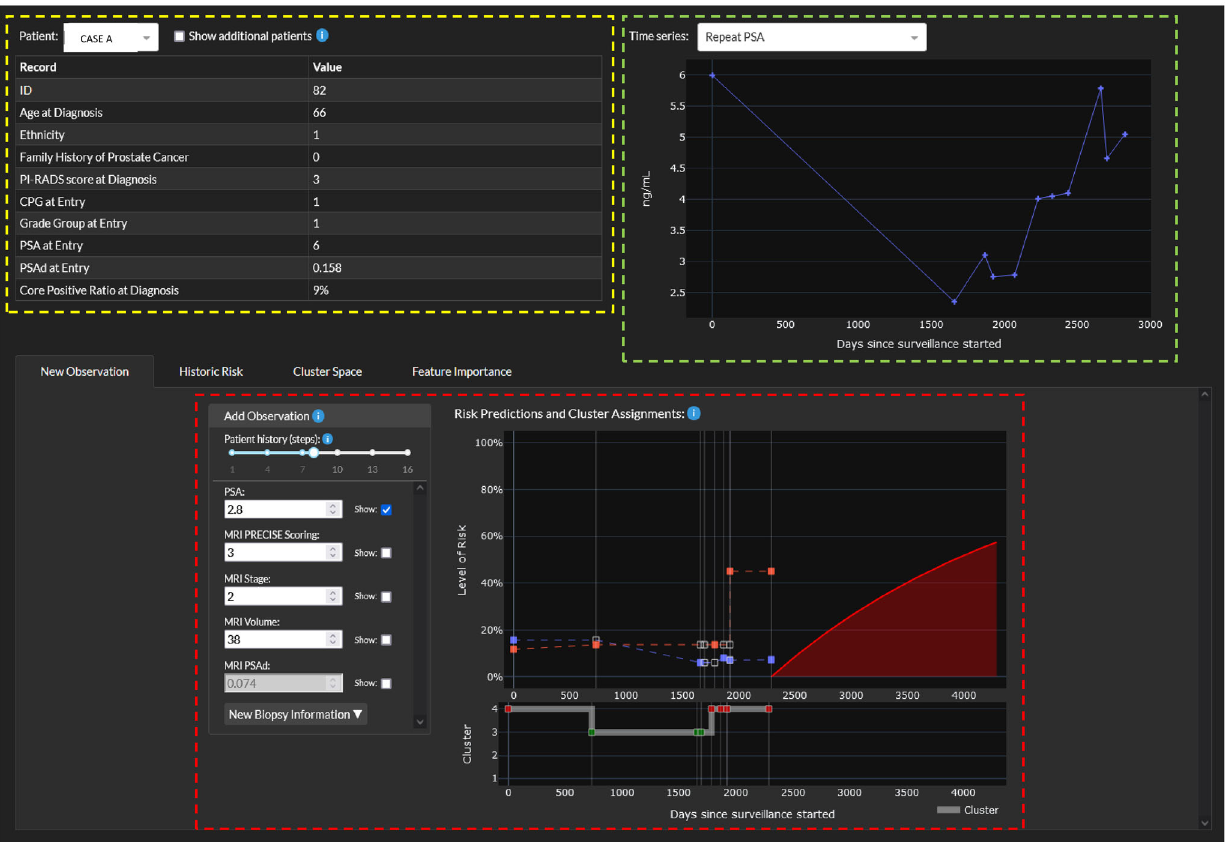
Fig. 4 Representative image from a demonstration interface of how the DDHL and AC-TPC algorithms would work in practice. (available at https://demo-dynamic-tte.herokuapp.com). Yellow box - data display on the patient ’ s baseline demographics. Green box - history of sequential readings, in this display PSA readings over time since starting AS. Red box - when a new data point is entered, it generates a predicted risk (red slope, in this case this is fl at) from that point onwards of developing a CPG3 event until altered by a new